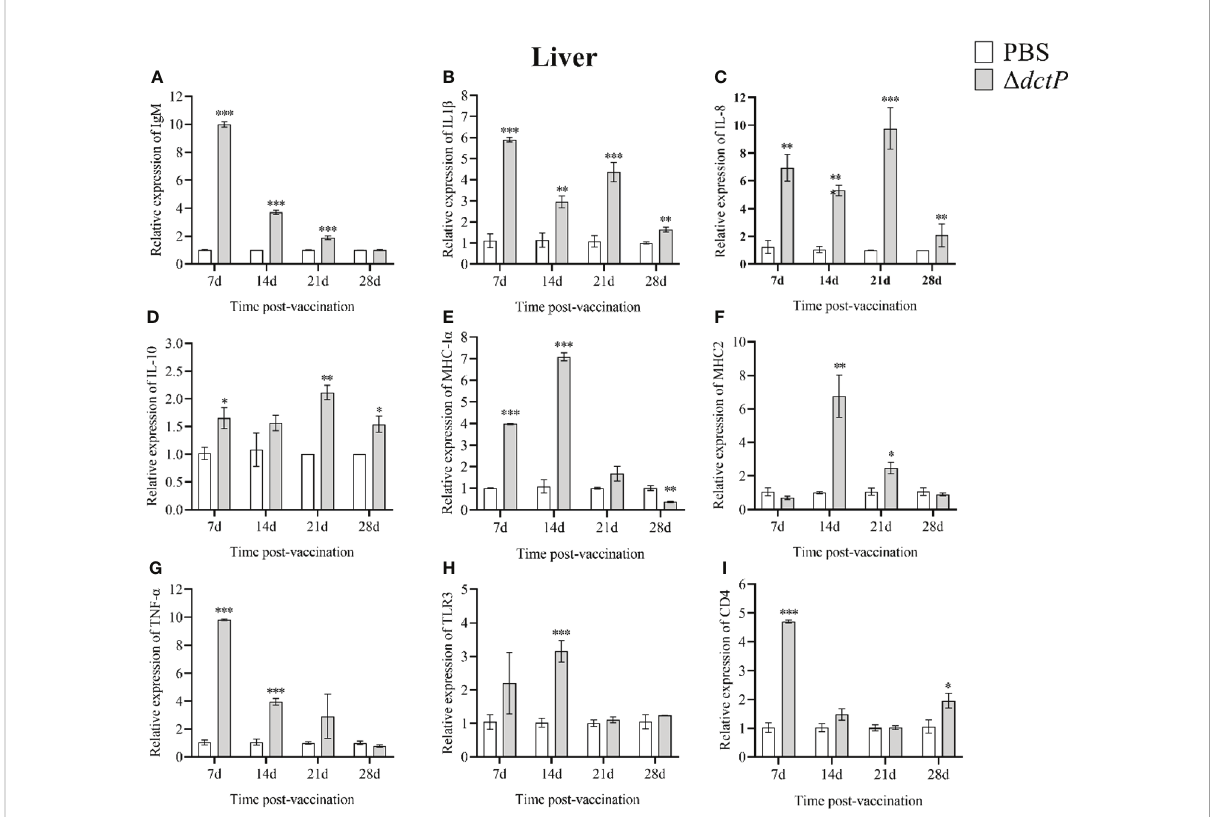
FIGURE 3 The expression levels of immune-related genes in the liver of pearl gentian groupers by qRT-PCR post-immunization. The mRNA level of each immune-related gene was normalized to that of b -actin and relative expression was calculated as the values of the vaccinated tissues by those of the controls. (A) IgM , (B) IL-1 b , (C) IL-8 , (D) IL-10 , (E) MHC-I a , (F) MHC2 , (G) TNF- a , (H) TLR3 , and (I) CD4 . Bars represented the mean relative expression (n=3) and error bars represent standard errors. The asterisks indicated signi fi cant differences: *(p < 0.05), **(p < 0.01) and ***(p < 0.001), between PBS group and D dctP